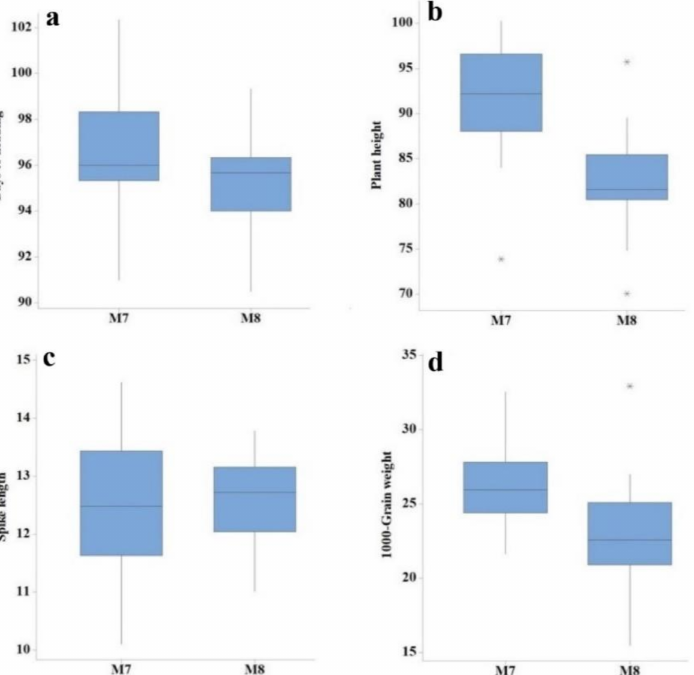
Figure 1. Boxplots showing median, minimum, maximum, and mean values ( a ) days to heading; ( b ) plant height; ( c ) spike length; ( d ) 1000-grain weight at the NIBGE location; * represents